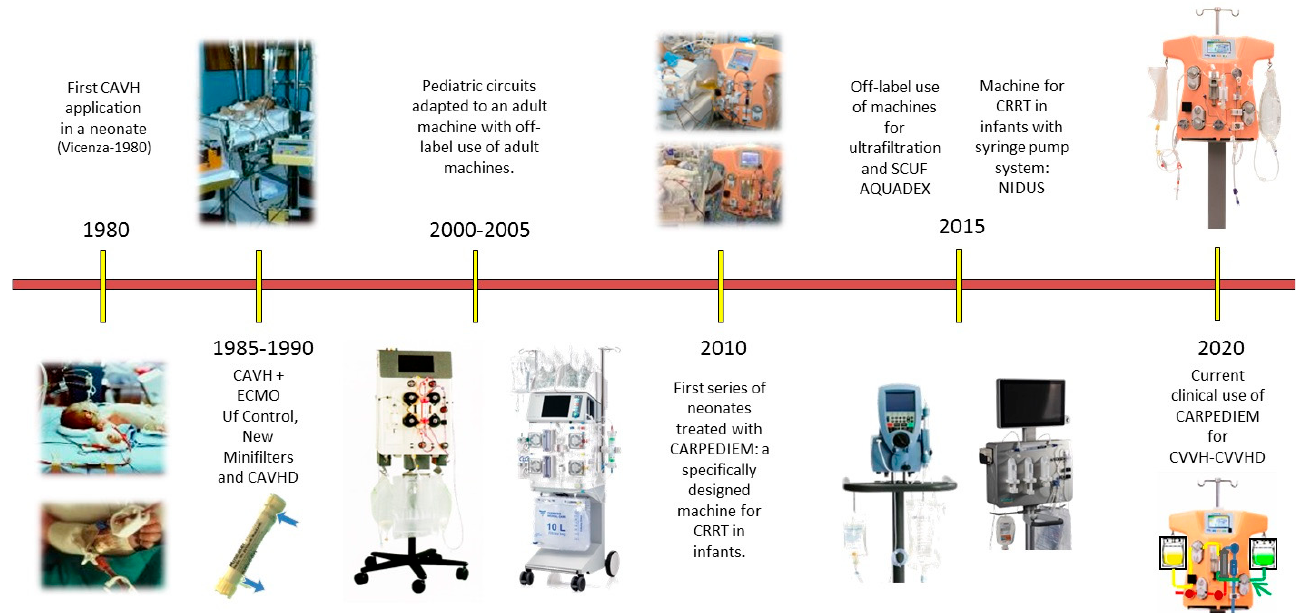
Figure 2. Evolution of continuous renal replacement therapy (CRRT) technology for infants and neonates (reproduced and modified with permission from Ronco C: Nefrologia Critica, Piccin Nuova Libraria, Padova, 2021). CAVH, continuous arteriovenous hemofiltration; SCUF, slow continuous ultrafiltration; ECMO, extracorporeal membrane oxygenation; Uf, ultrafiltration; CAVHD, continuous arteriovenous hemodialysis; CARPEDIEM, cardio renal pediatric dialysis emergency machine; CVVH, continuous veno-venous hemofiltration; CVVHD, continuous veno-venous hemodialysis.